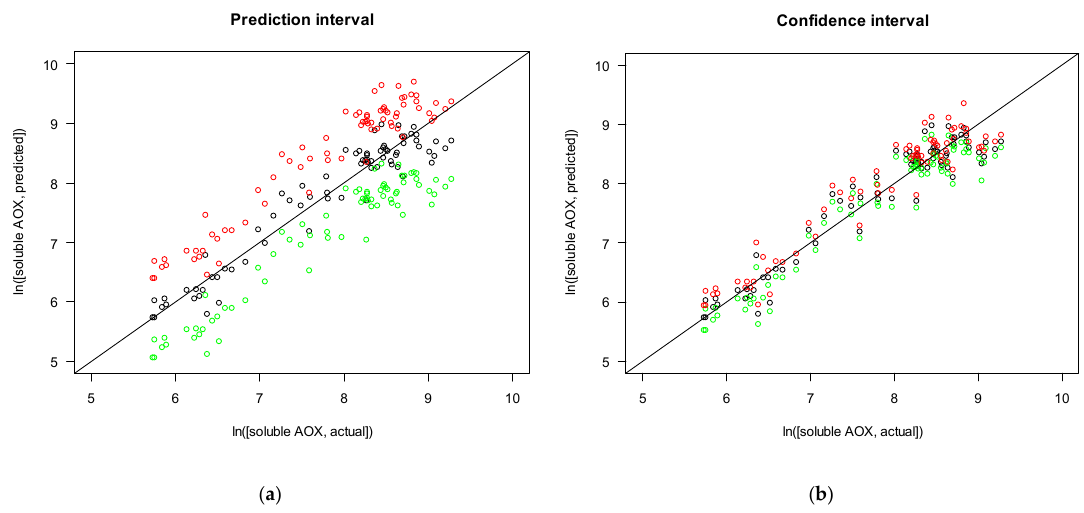
Figure 8. Prediction interval ( a ) and confidence interval ( b ) per observation for the model predicting the soluble AOX concentration (minimum points are indicated in green, maximum points in red, and fitted points in black).